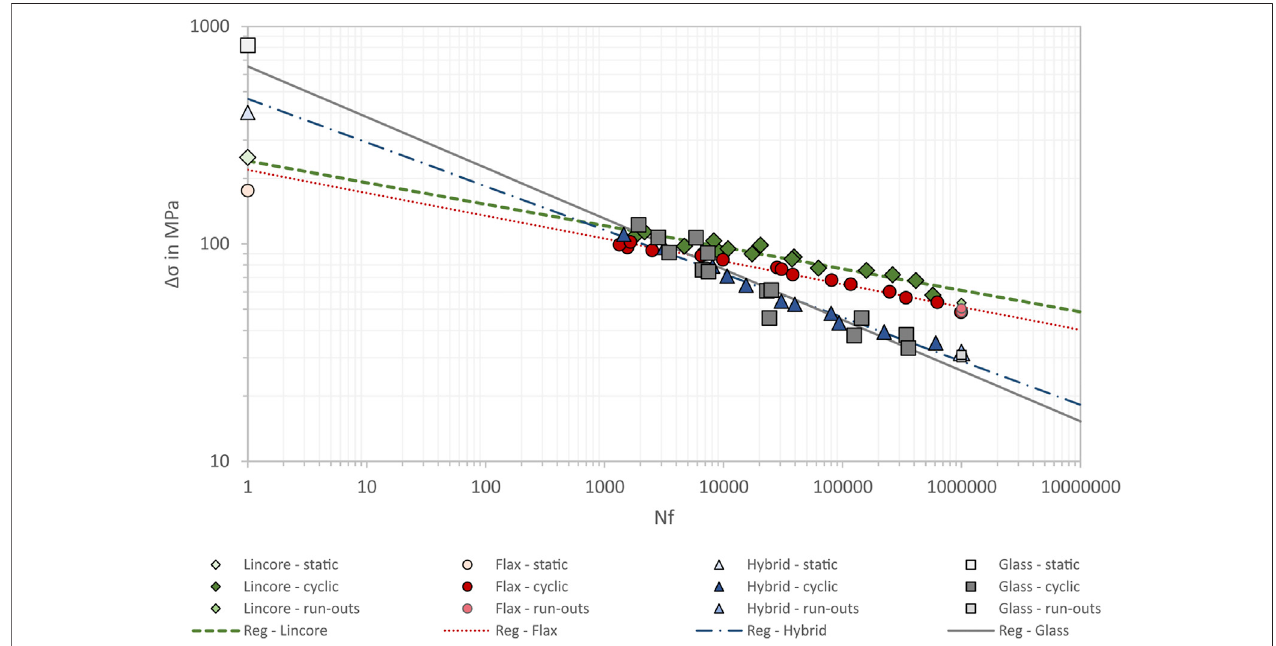
FIGURE 8 | Results from the fatigue tests for the glass fi ber – reinforced composite, the hybrid composite made of fl ax and glass (2 × 2 outer glass layers + 3 fl ax layers in the core) and the composite made of the Lincore fl ax roving and the fl ax staple fi ber yarn V2.